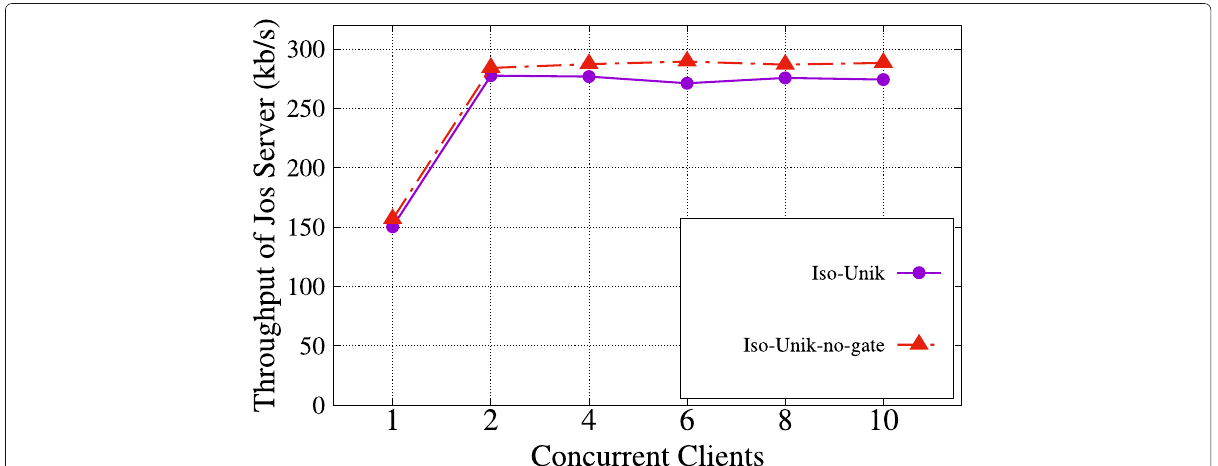
Fig. 5 The throughput (in kbytes/second) of JOS web server and different concurrent clients